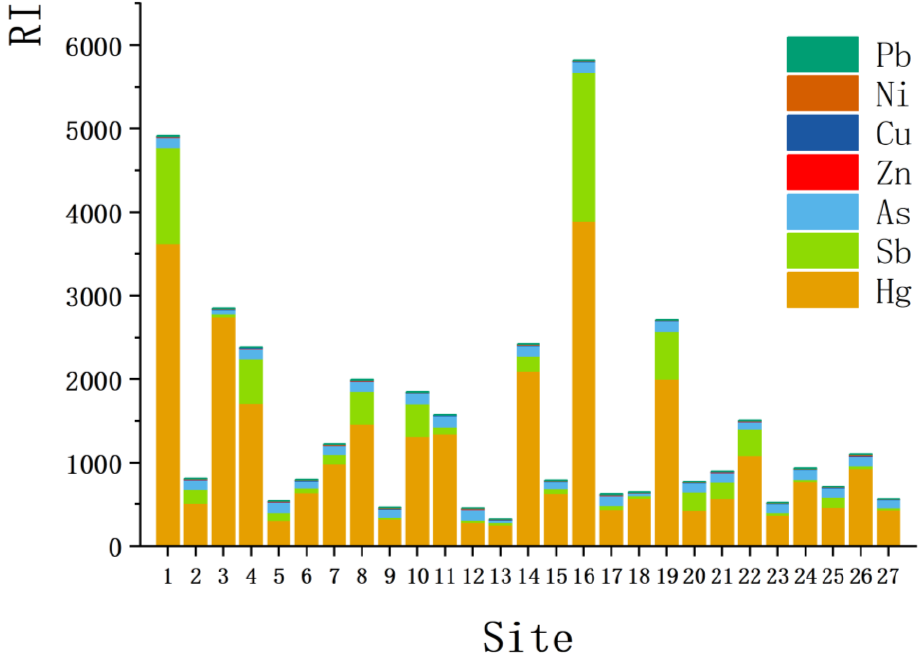
Figure 3. Ecological potential risk index of the various PTEs recorded in soils of the study area.